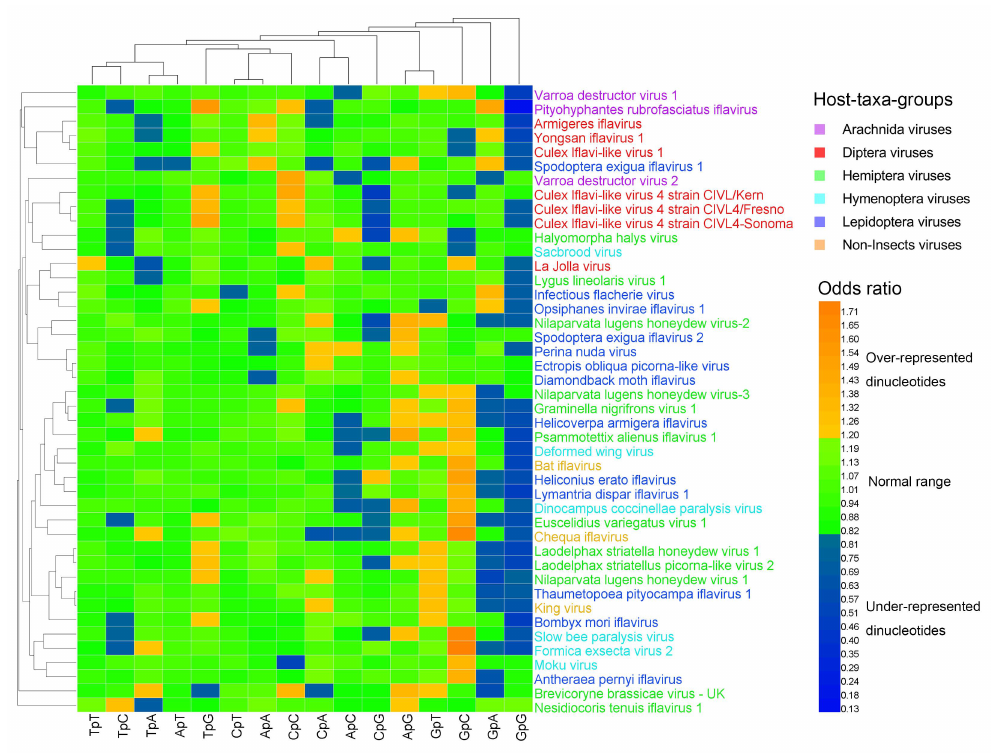
Figure 2. Heat map of the dinucleotide composition at the 2nd–3rd codon positions. Iflavirus genomes were clustered independently of viral host taxa, implying that there exist other factors behind dinucleotide composition. The viruses and dinucleotides were clustered by the Average Linkage method using the Euclidean